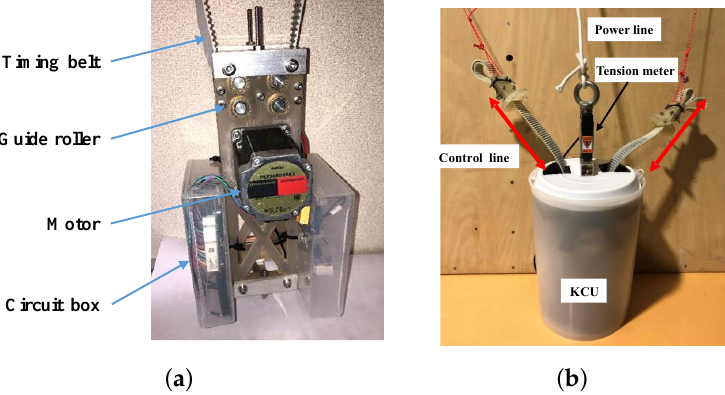
Figure 6. Design of the KCU, including structural frame, transmission belts, electronic circuit and motors. ( a ) The core of the KCU without casing and ( b ) after putting the casing on.